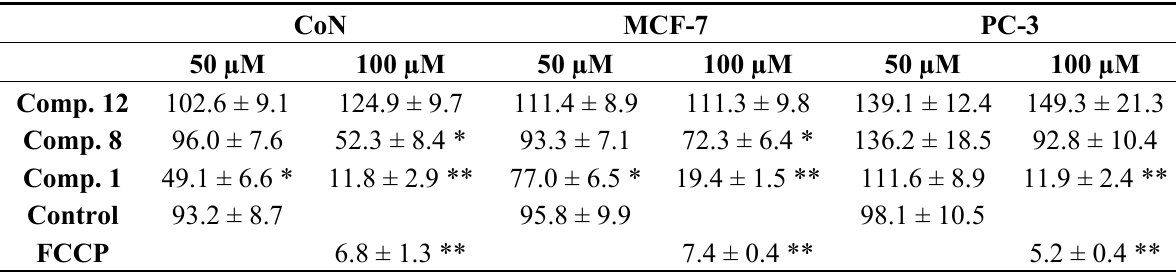
Table 2. Compounds 1 , 8 and 12 treatment-induced changes in the mitochondrial membrane permeabilities for CoN, MCF-7 and PC-3 cells. The cells were stained with rhodamine 123, and then analyzed by flow cytometry. The table shows the percentage values of rhodamine 123 stained cells treated without or with compounds 1 , 8 and 12 (50–100 μ M) for the different cell lines (* p < 0.05 or ** p < 0.001 vs. control treated cells, assigned 100%). As positive control, FCCP (10 μ M) was used.